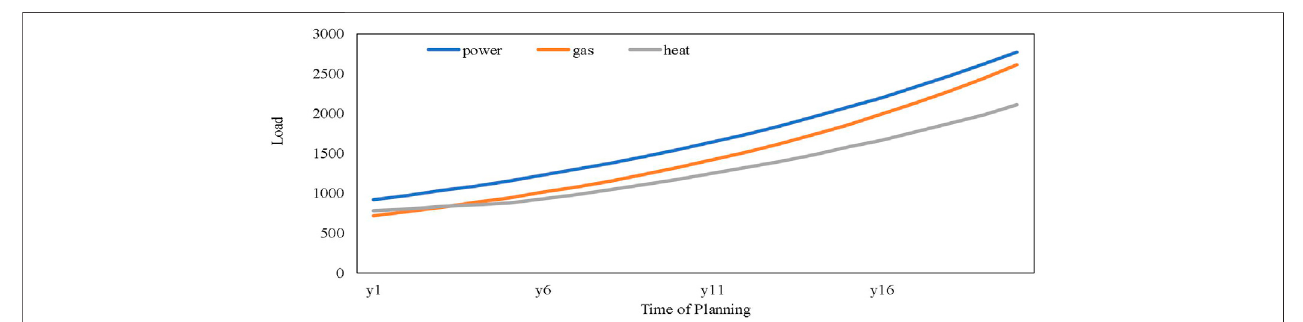
FIGURE 4 | Typical annual load forecasting curve.